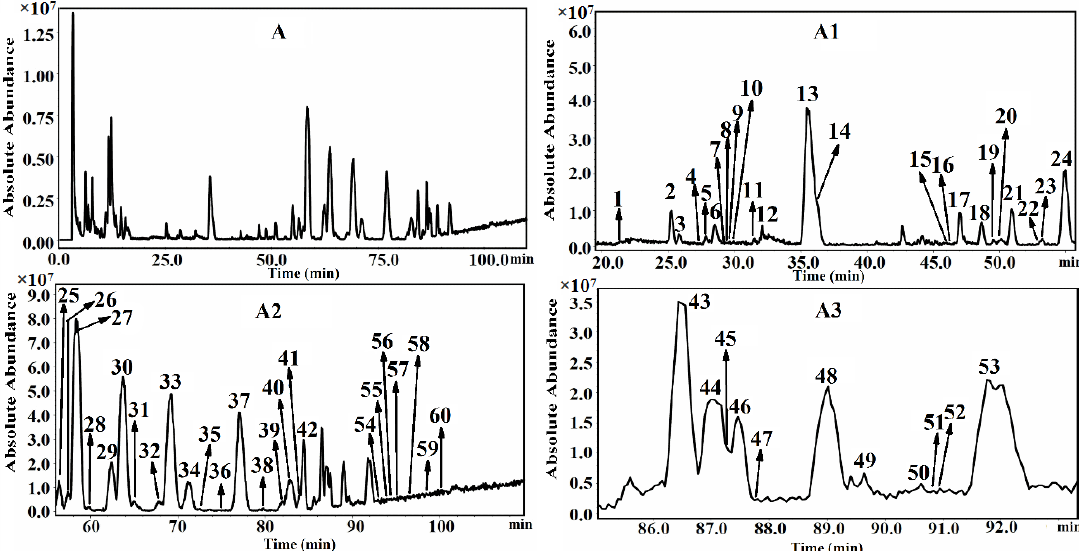
Figure 2. The TIC of Jilin GRR in negative ion detection mode ( A ) and its corresponding amplified chromatograms ( A1 , A2 , A3 ).